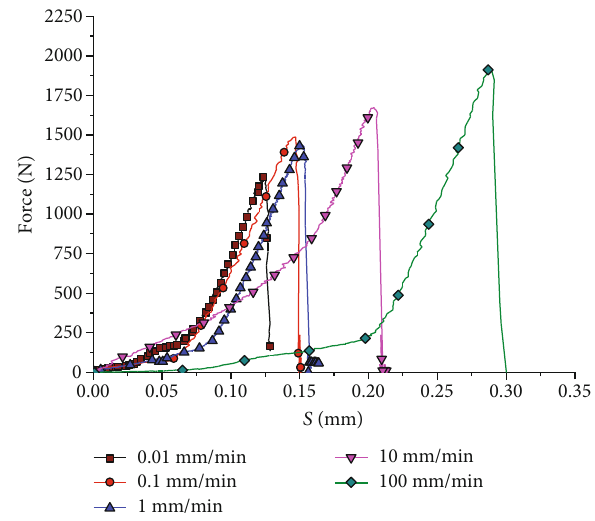
Figure 4: Load-displacement curves during the fracture tests for di ff erent loading